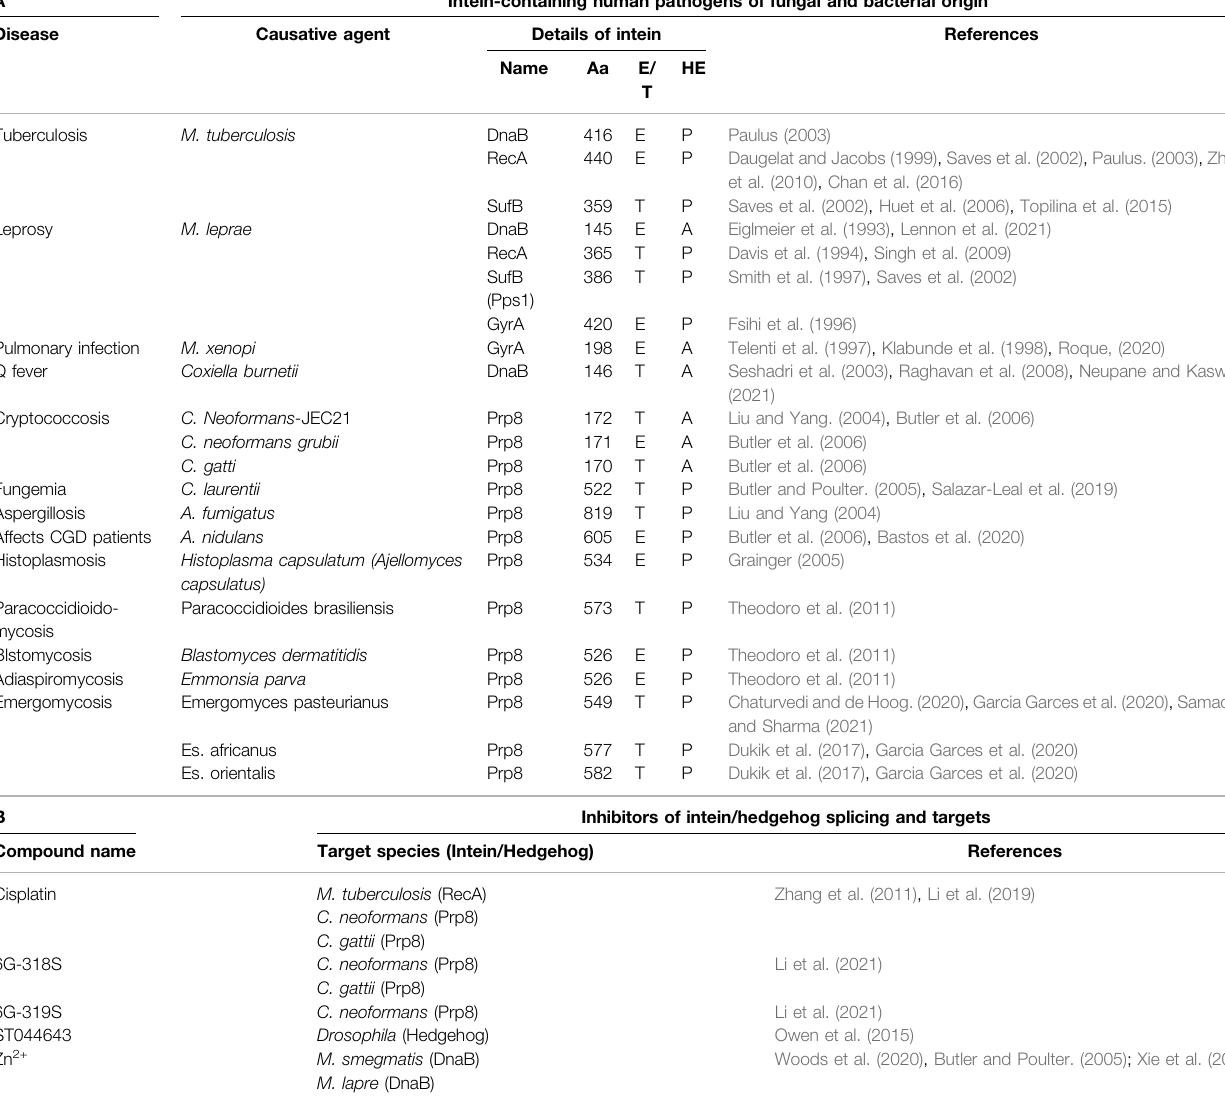
TABLE1 | Inteins in human pathogens and intein splicing